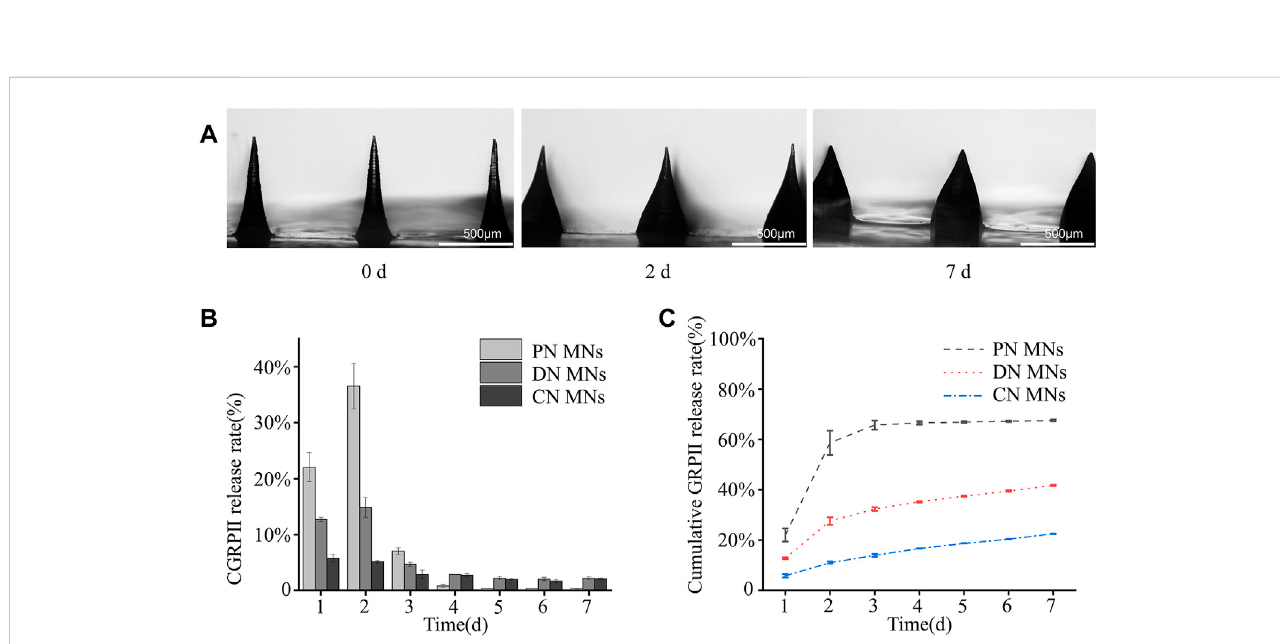
FIGURE 6 DegradationoftheMNsandCGRPIIrelease. (A) OpticalimagesofthedegradationoftheDNMNsinPBSsolutionfordifferenttimepoints(0,2and7 day). (B) Thereleasepro fi lesofCGRPIIfromdifferentMNsinPBSsolutionat37 ° C. (C) CumulativeCGRPIIrelease invitro fromdifferentMNsinPBSsolutionat37 ° C, shown as a function of time. Points represent means ± SD. ( n =